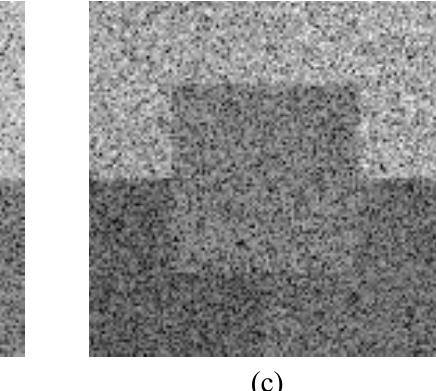
Figure 10. X-band amplitude simulated polarimetric SAR images: (a) HH, (b) HV and (c) VV